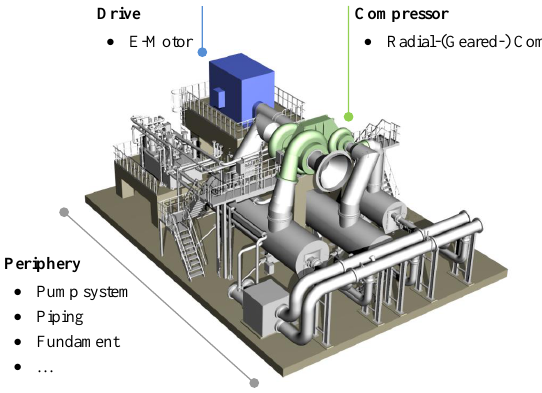
Fig. 6: A compressor train (source: Siemens AG) Figure 6: A compressor train (source: Siemens